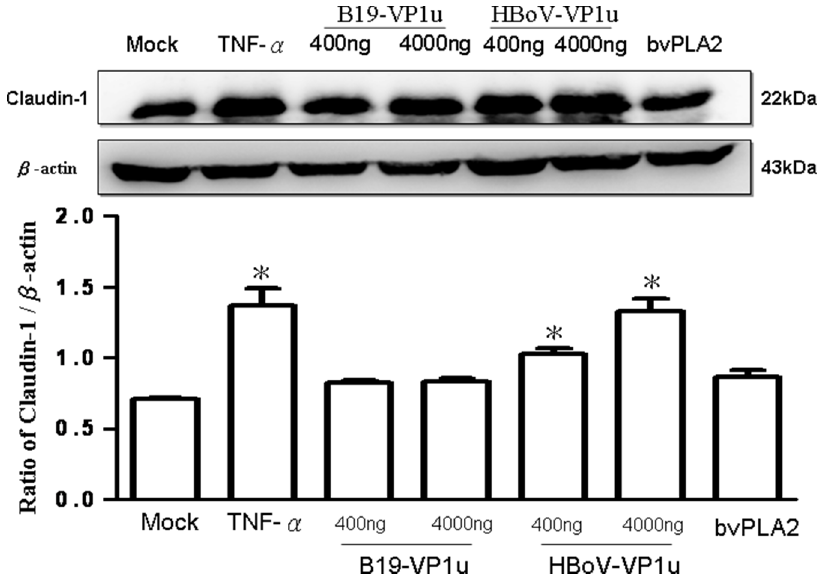
Figure 2. Expression of claudin-1. Cell lysates obtained from A549 cells treated with PBS (mock), TNF- a (10 ng/ml), two dosages of recombinant B19-VP1u and HBoV-VP1u (400 ng/ml and 4000 ng/ml) and bee venom PLA2 (10 ng/ml) were probed with antibodies against claudin-1. Quantified result was shown in the lower panel. Similar results were observed in three independent experiments and * indicates the significant difference as compared to the mock, P , 0.05. doi:10.1371/journal.pone.0107970.g002 PLOS ONE |